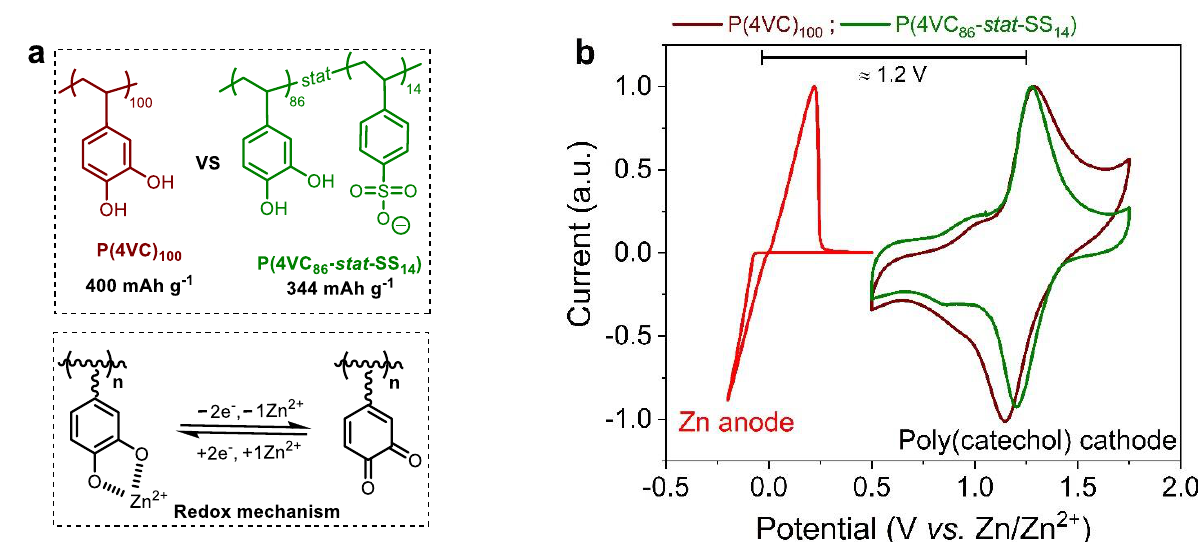
Figure 1. Design of Zn || poly(catechol) aqueous battery. ( a ) Chemical structure of poly(catechol) homo and copolymers, along with simplified redox mechanism; ( b ) CVs of Zn anode and P(4VC) 100 or P(4VC 86 - stat -SS 14 ) cathodes in 4 m Zn(TFSI) 2 - H 2 O aqueous electrolyte. The CVs were recorded in a three-electrode configuration with polymer-based electrode (or Ti foil), Zn wire and Zn foil as the working, reference and counter electrodes, respectively at 5 mV s −1 .